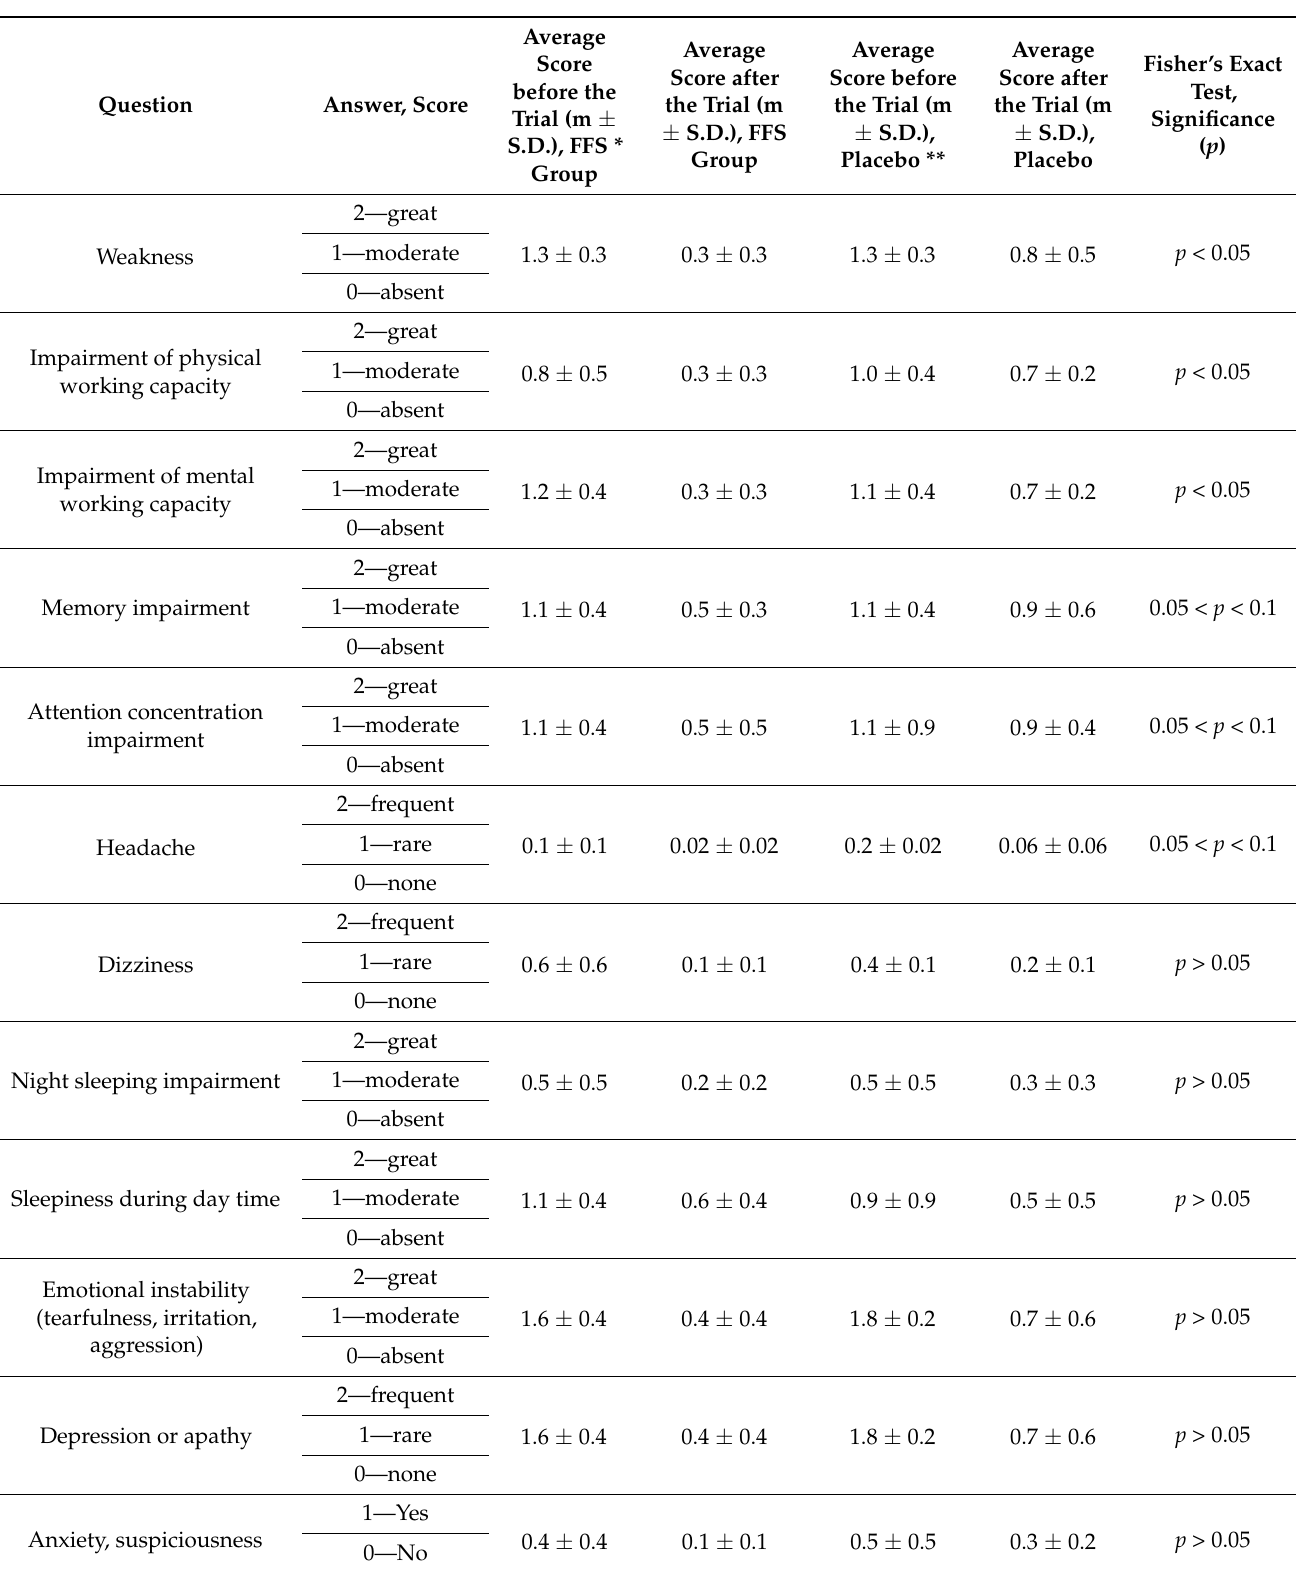
Table 3. Subjective opinions of post-COVID patients (n = 97, moderate COVID